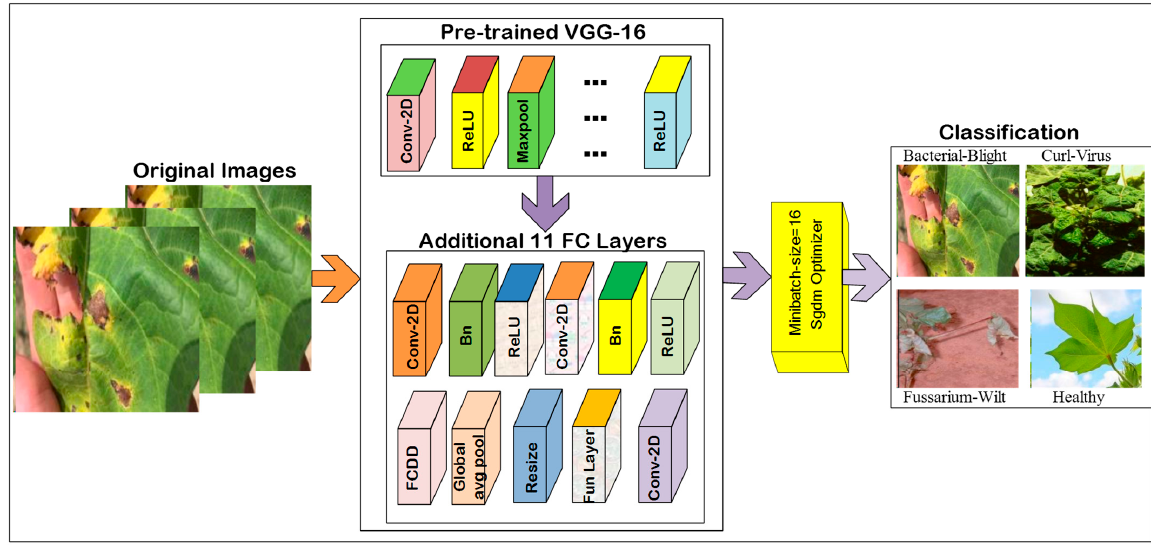
Figure 1. Cotton disease detection model.